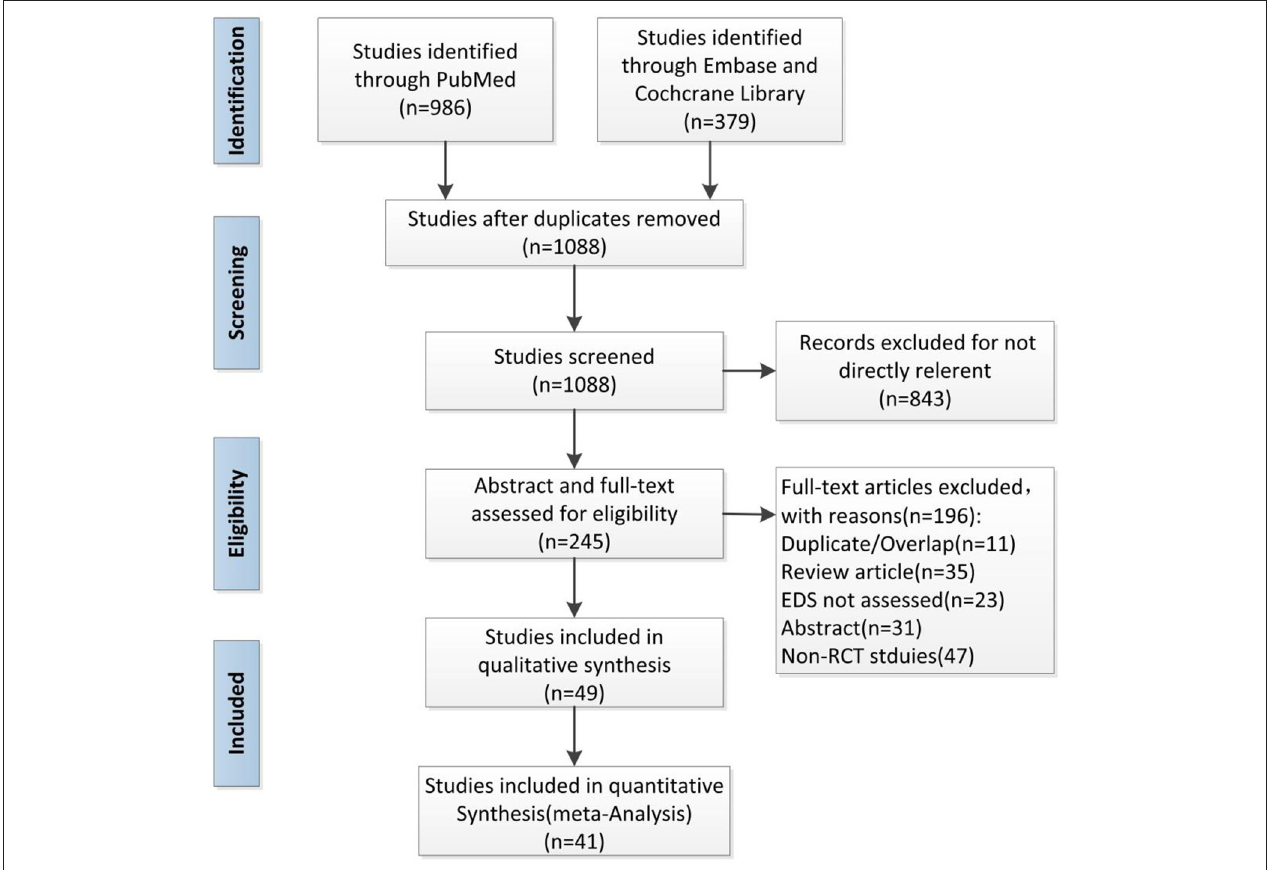
FIGURE 1 | Screening process for study selection and